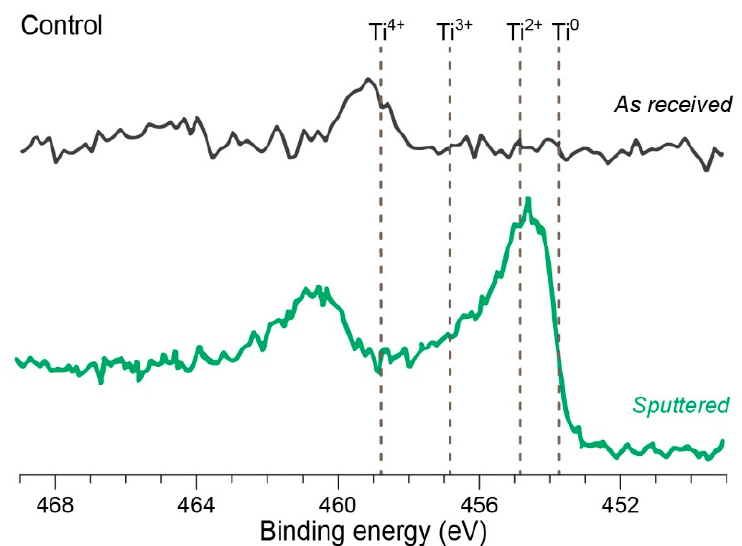
Figure 5. Examples of XPS spectra of titanium implant surfaces. Figure adapted from [51] with permission from The Royal Society of Chemistry.